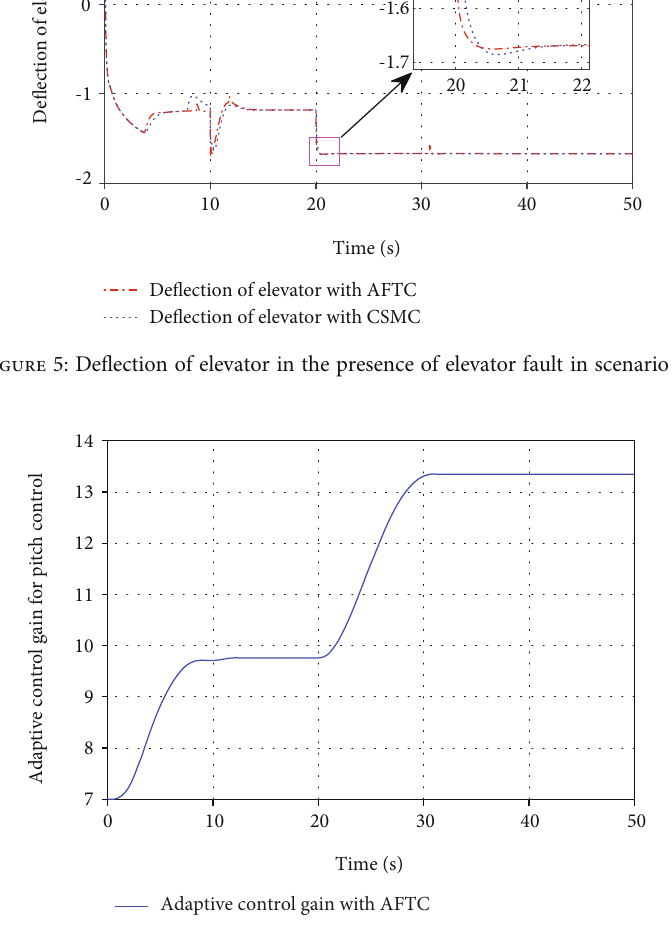
Figure 6: Change of adaptive control parameter in the presence of elevator fault in scenario